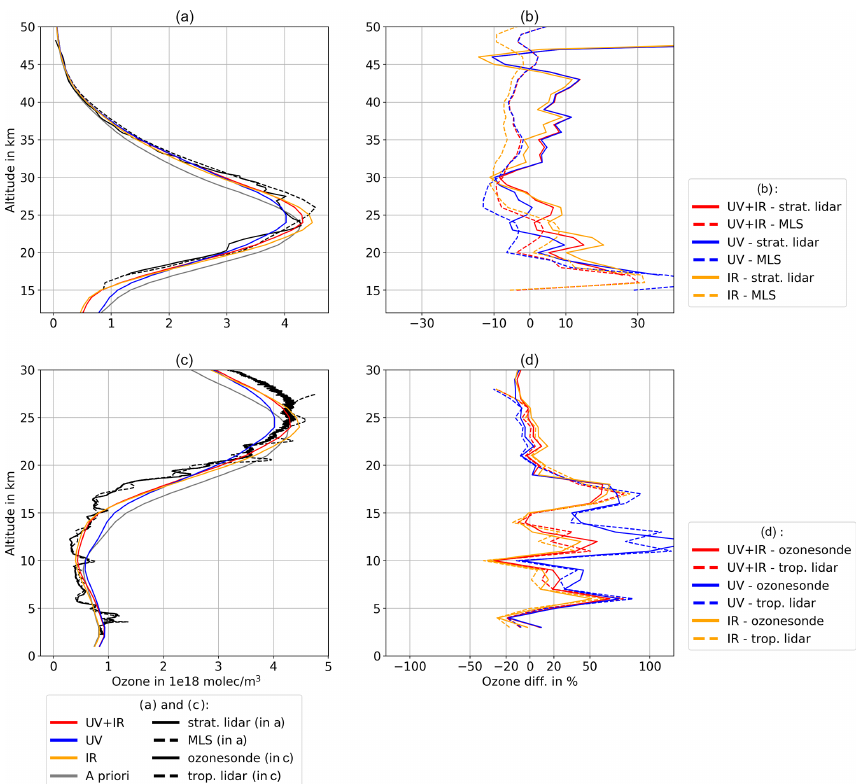
Figure 2. Comparison between UV + IR, UV-only, and IR-only ozone profile retrievals and collocated stratospheric lidar and MLS mea- surements ( a and b ) and collocated tropospheric lidar and ozonesonde profiles ( c and d ). The TROPOMI and CrIS data were obtained at 34.2 ◦ latitude and − 117 . 9 ◦ longitude on 27 September 2018 at 21:20:11LT. All measurements, the MLS ozone profile, the ozonesonde, and tropospheric and stratospheric lidar sounding from Table Mountain facility, are within 100km distance of TROPOMI/CrIS. The time difference is 25min for MLS and between 6 and 8h (nighttime profile) for the lidars and ozonesonde.